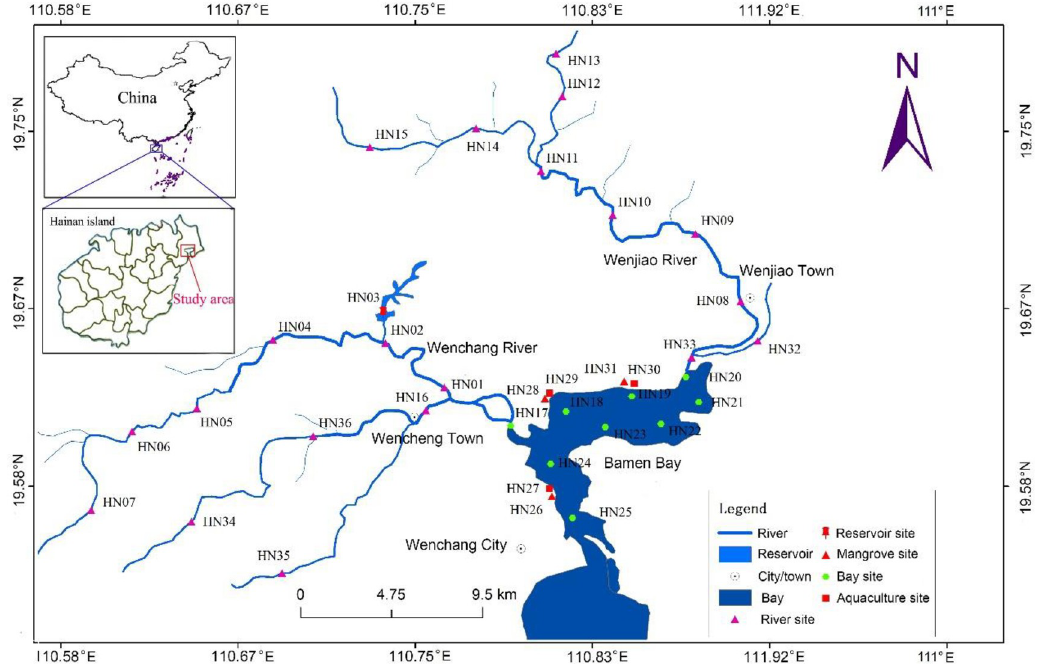
Fig 1. Location of study site and sampling stations in Bamen Bay watershed. Map of Bamen Bay watershed are illustrated by authors using ArcGis Software. Map and shapefile of China and Hainan Province are from Map Standard Service system (http:// bzdt.ch.mnr.gov.cn/), and there is no copyright issue.